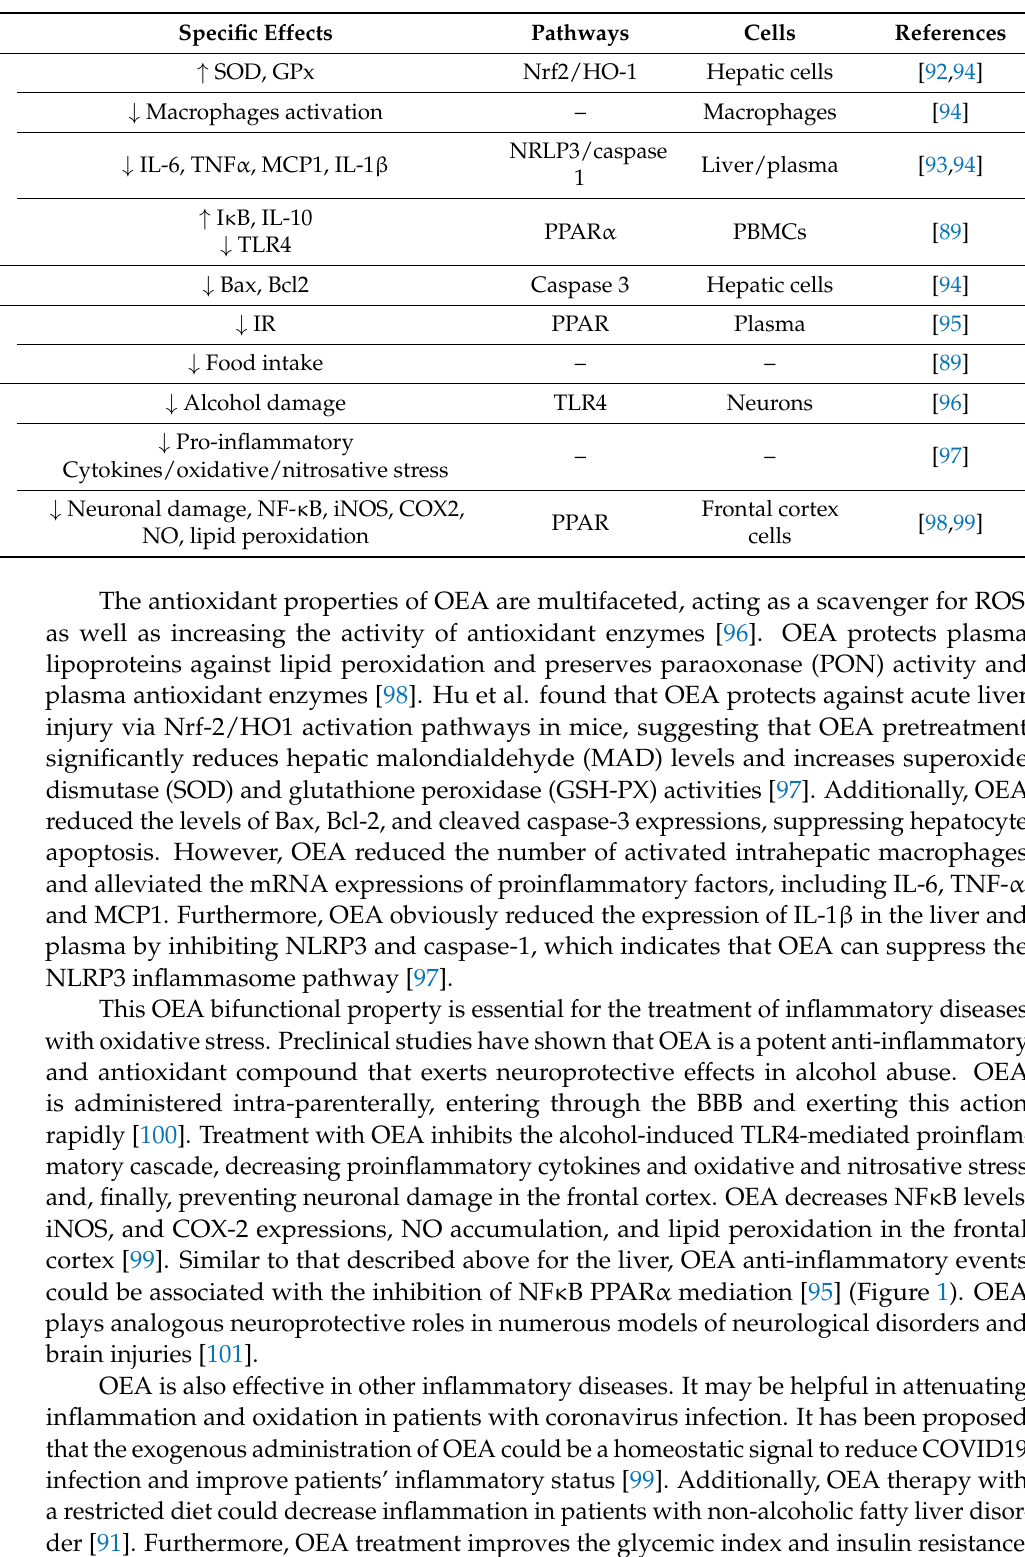
Table 2. Effects of oleoylethanolamide (OEA) on signaling pathways, and types of immune cells